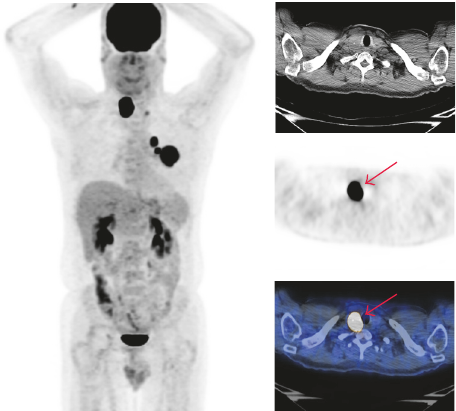
Figure 1: A 63-year-old male with B-cell lymphoma demonstrated bilateral thyroid lobe enlargement with focal increased metabolic activity in left thyroid lobe (Case 8). The arrow only refers to the hypermetabolic incidental thyroid lesion.